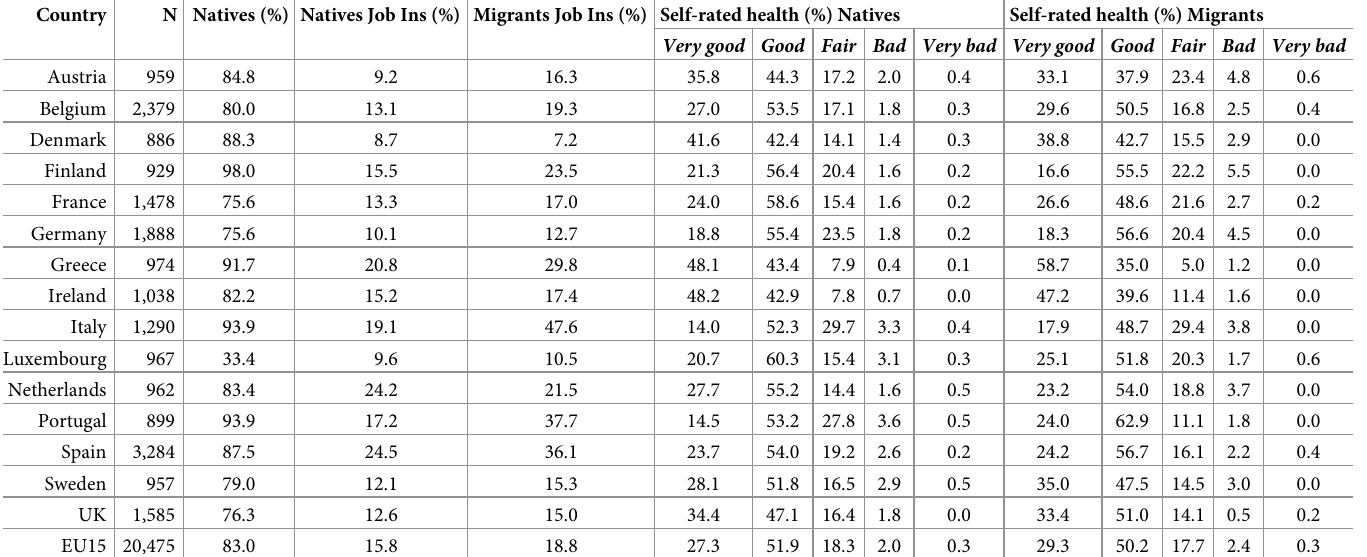
Table 1. Characteristics of the study